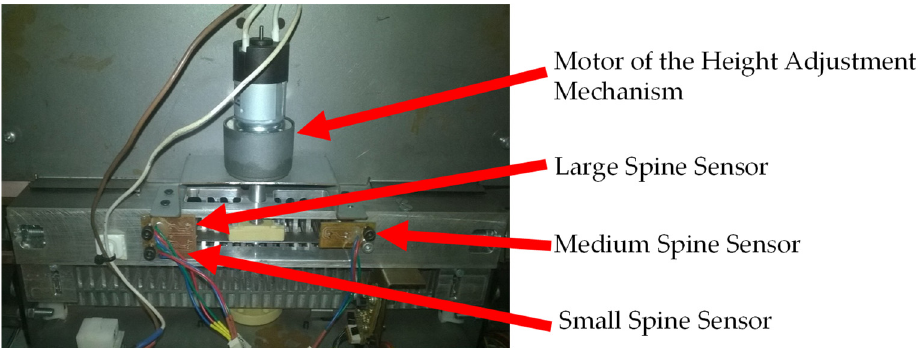
Figure 7. Document height adjustment mechanism showing which sensor indicates the height for different spine